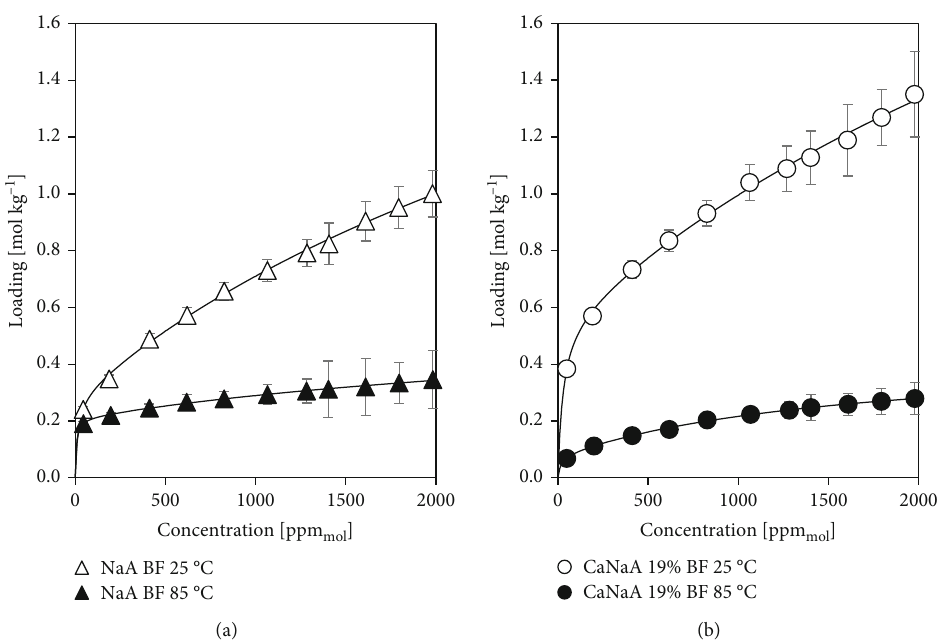
Figure 8: H S isotherms at 25 ° C and 85 ° C on (a) NaA BF and (b) CaNaA 19% BF. 2